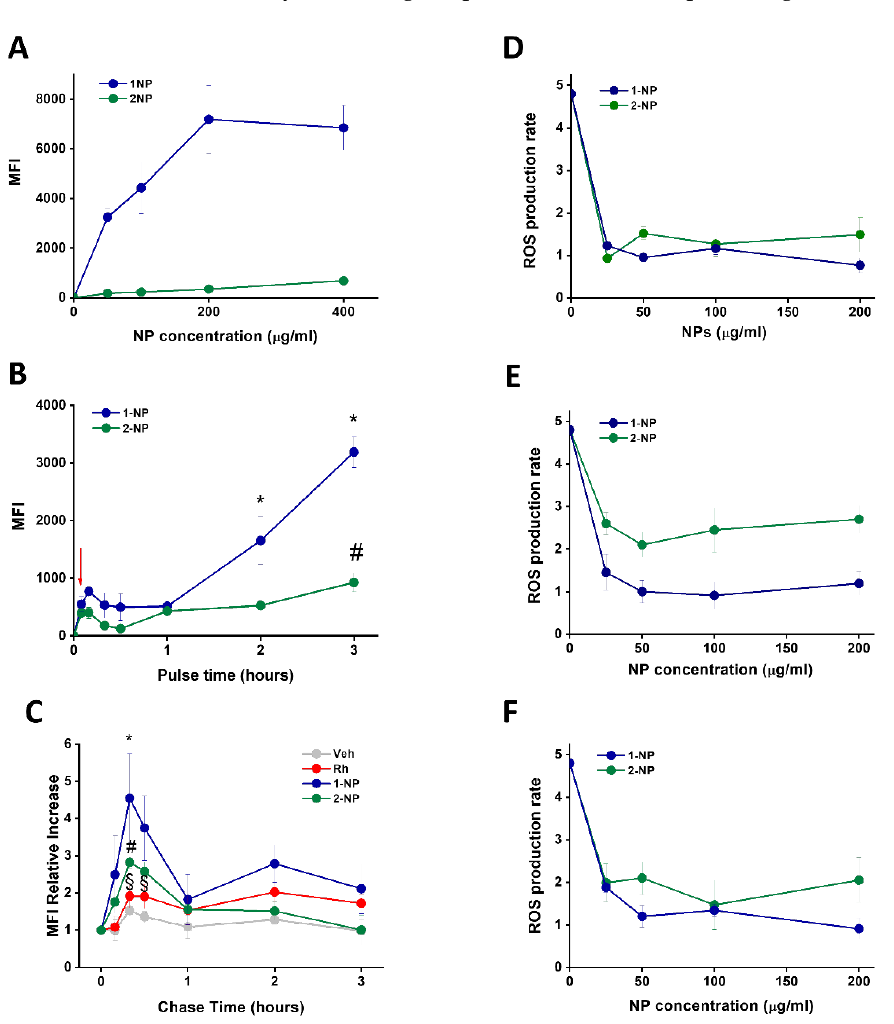
Figure 4. Capture, intracellular disassembly poly(lipoic acid) and antioxidative efficacies of F127@ 1 - NP and F127@ 2 -NP in t-BHP treated NRVMs. ( A ) Neonatal rat ventricular myocytes (NRVMs) were incubated with the indicated concentrations of fluorescently-labeled F127@ 1 -NP and F127@ 2 -NP for 3 h in DMEM plus 1% FCS and analyzed, after washings in NP-free medium, by flow cytofluorim- etry. Data (Mean Fluorescence Intensity) are the mean of 3 independent experiments ± SE. ( B ) NRVMs were incubated with F127@ 1 -NP and F127@ 2 -NP (100 µg/mL) for the indicated time lapses and analyzed for their MFI by flow cytofluorimetry as above (data are mean ± SE, N = 3). * p < 0.001 vs. 5 min, # p < 0.05 vs. 5 min by two- way ANOVA with post hoc Tukey’s multiple comparison test. The red arrow indicates the pulse time with NPs (5 min) used for pulse – chase experiments described in panel ( C ). Cells were pulsed for 5 min as in panel ( B ), washed 3 times with PBS and further chased in cell medium with no NPs for the indicated times. Equivalent amounts of the buffer (Veh) or the fluorophore rhodamine (Rh) were used as controls. MFI acquired by spectrofluorimetry after cell recovery are expressed as relative values compared to the MFI one after the pulse time (taken as 1). Data are mean ± SE (N = 3). * p < 0.01 vs. 5 min, # p < 0.05 vs. 5 min, § p < 0.01 vs. NPs by two-way ANOVA with post hoc Tukey’s multiple comparison test. ( D – F ) NRVMs were preincubated with the shown concentrations of F127@ 1 -NP and F127@ 2 -NP for 1 h ( D ), 3 h ( E ) and 6 h ( F ), washed and further incubated with the CM-H 2 DCFDA. The ROS production was initiated with t-BHP (100 µM). ROS production rate (ROS production/time) is reported as a function of NP dose. Data are mean ± SE (N = 3).